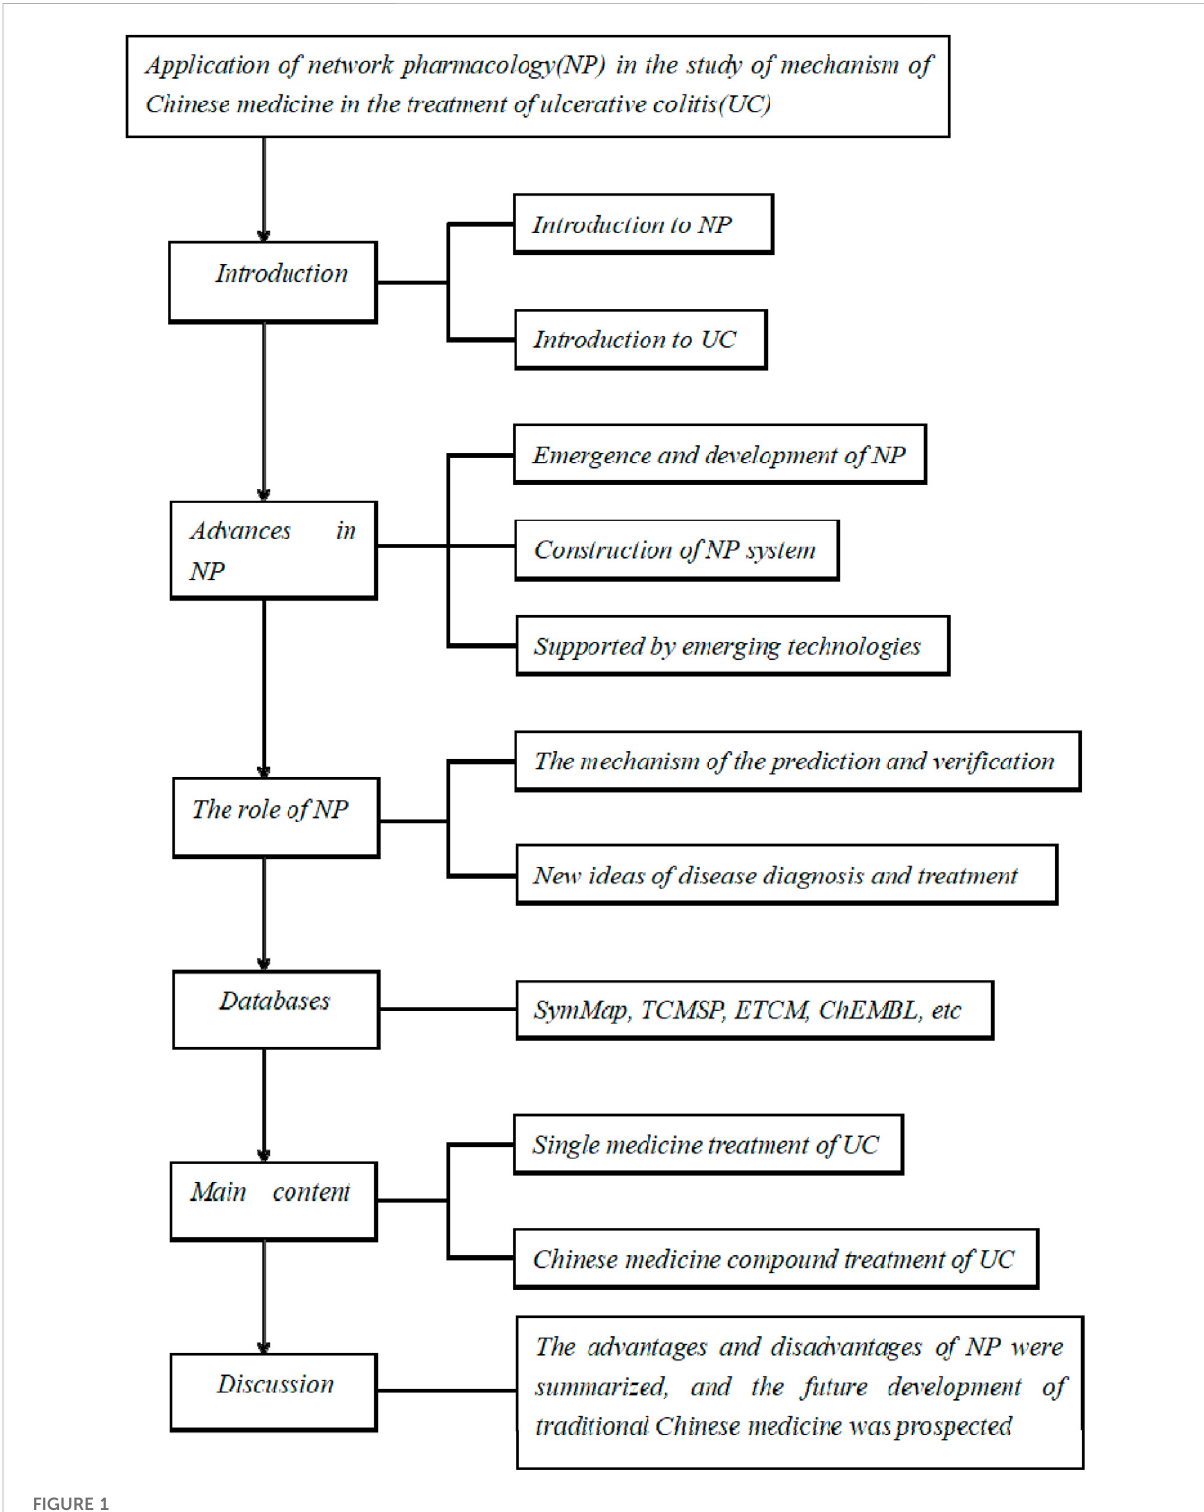
FIGURE 1 Framework fi